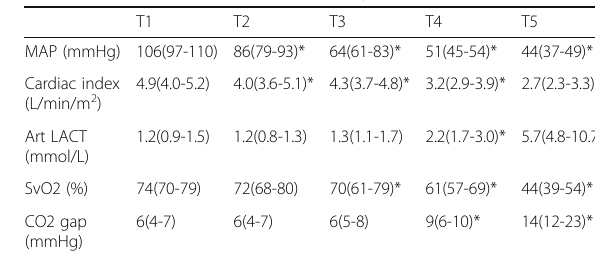
Table 83 (abstract A264). Global hemodynamic variables